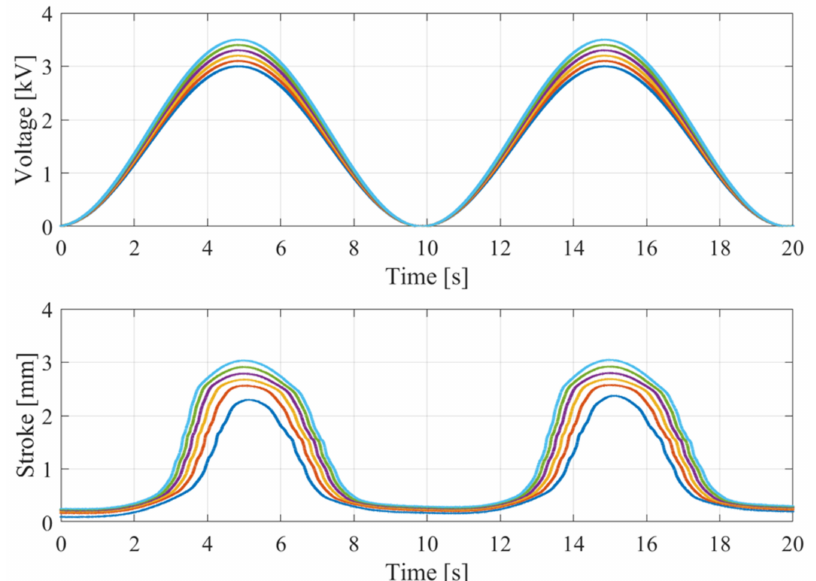
Figure 19. The upper part shows a sinusoidal voltage signal applied as input, at the frequency of 0.1 Hz. The different colors represent signals of different amplitudes set as the input, which vary in the range 3–3.5 kV with increments of 0.1 kV. In the lower part, the corresponding stroke reached by the DEA is